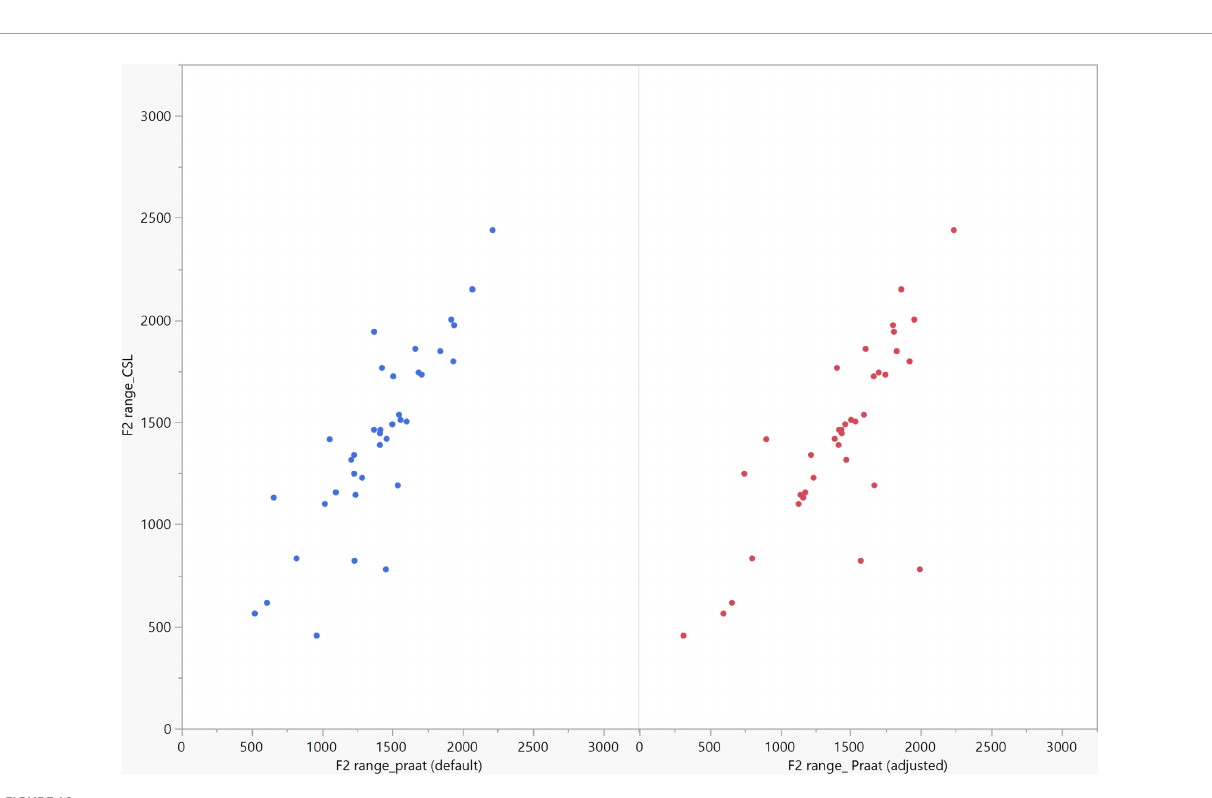
FIGURE10 Correlation between the F2 ranges of five vowels calculated from Computerized Speech Lab (CSL) F2 data and Praat F2 data using the default and adjusted settings. The calculated F2 ranges were highly correlated between CSL and both Praat settings (default settings: rs = 0.850, n = 37, p < 0.0001*; adjusted settings: rs = 0.732, n = 37, p <